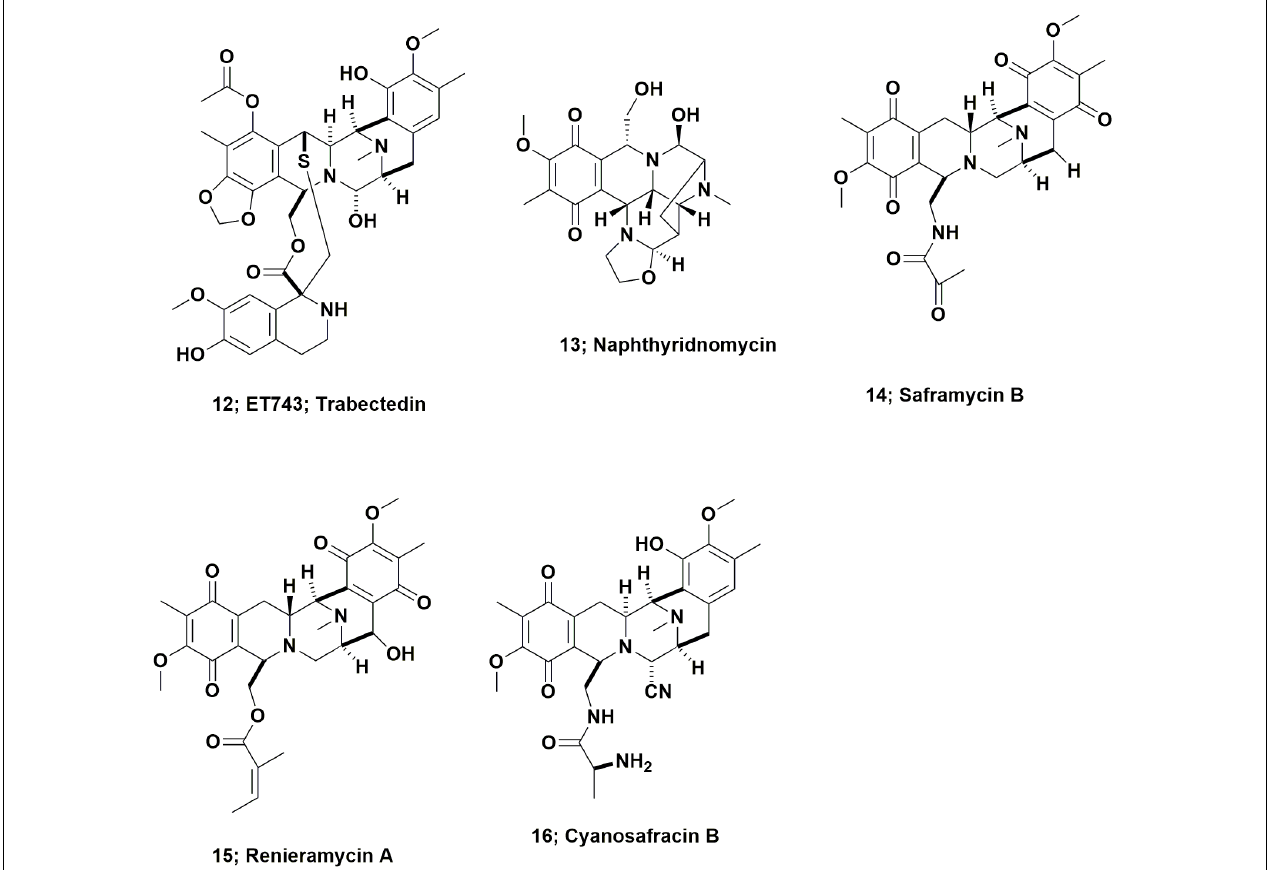
FIGURE 4 | Ecteinascidin 743 and